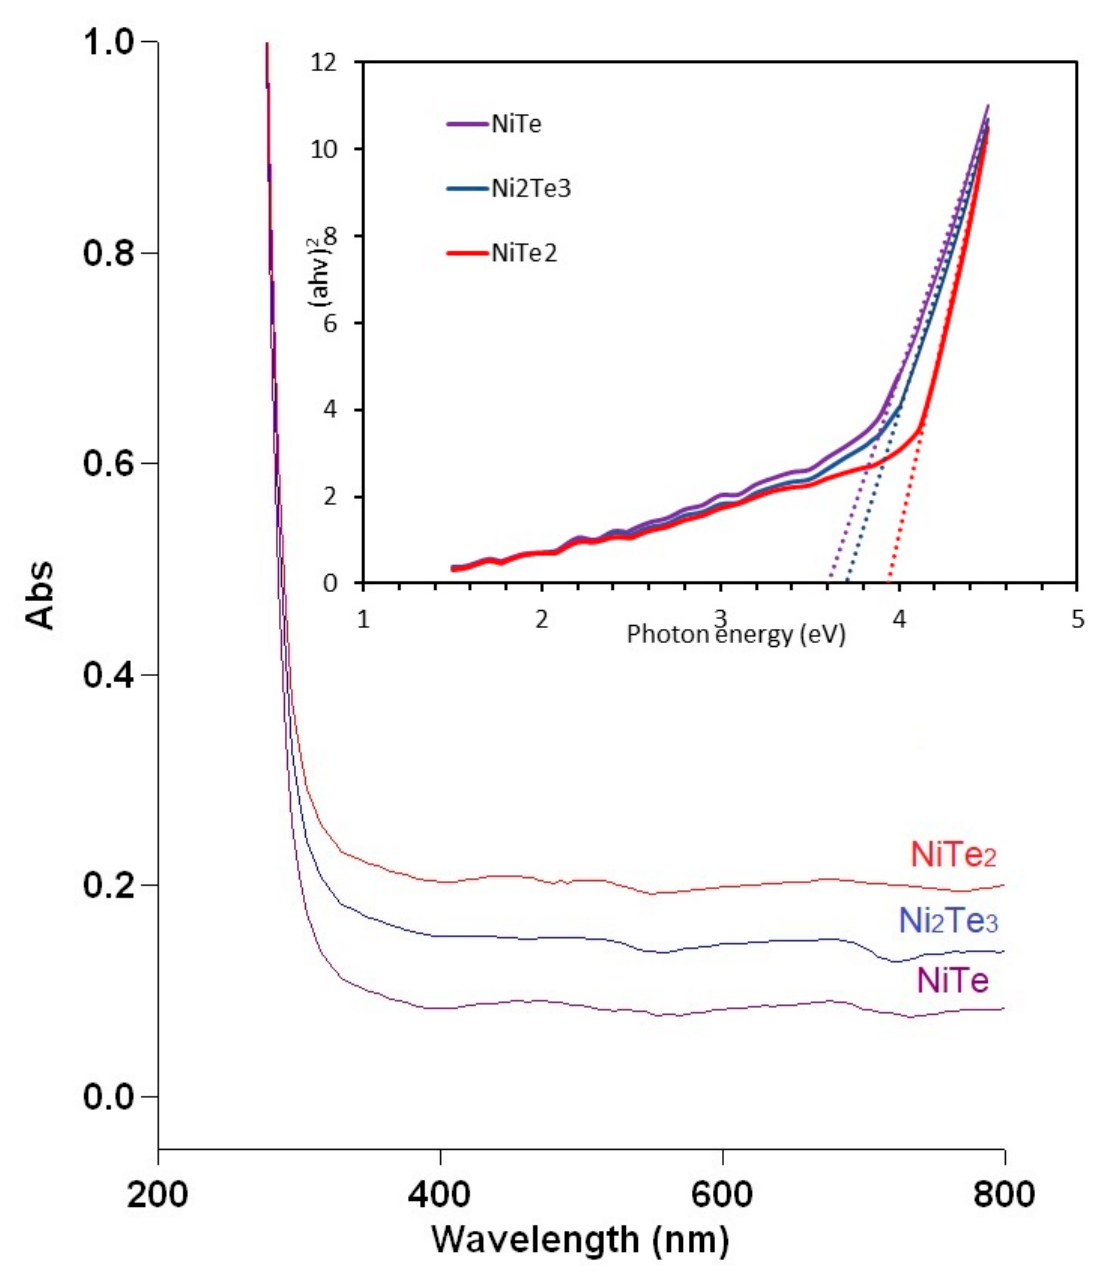
Figure 8. UV-VIS spectra of different nickel tellurides: NiTe, NiTe 2 , and Ni 2 Te 3 prepared by solvent-free mechanochemical synthesis. The inset represents the Tauc plots used for the determination of the band gap.